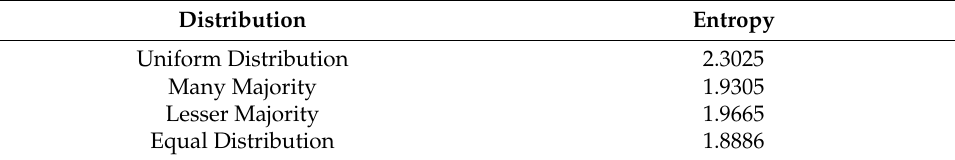
Table 10. Entropy of chosen distributions.